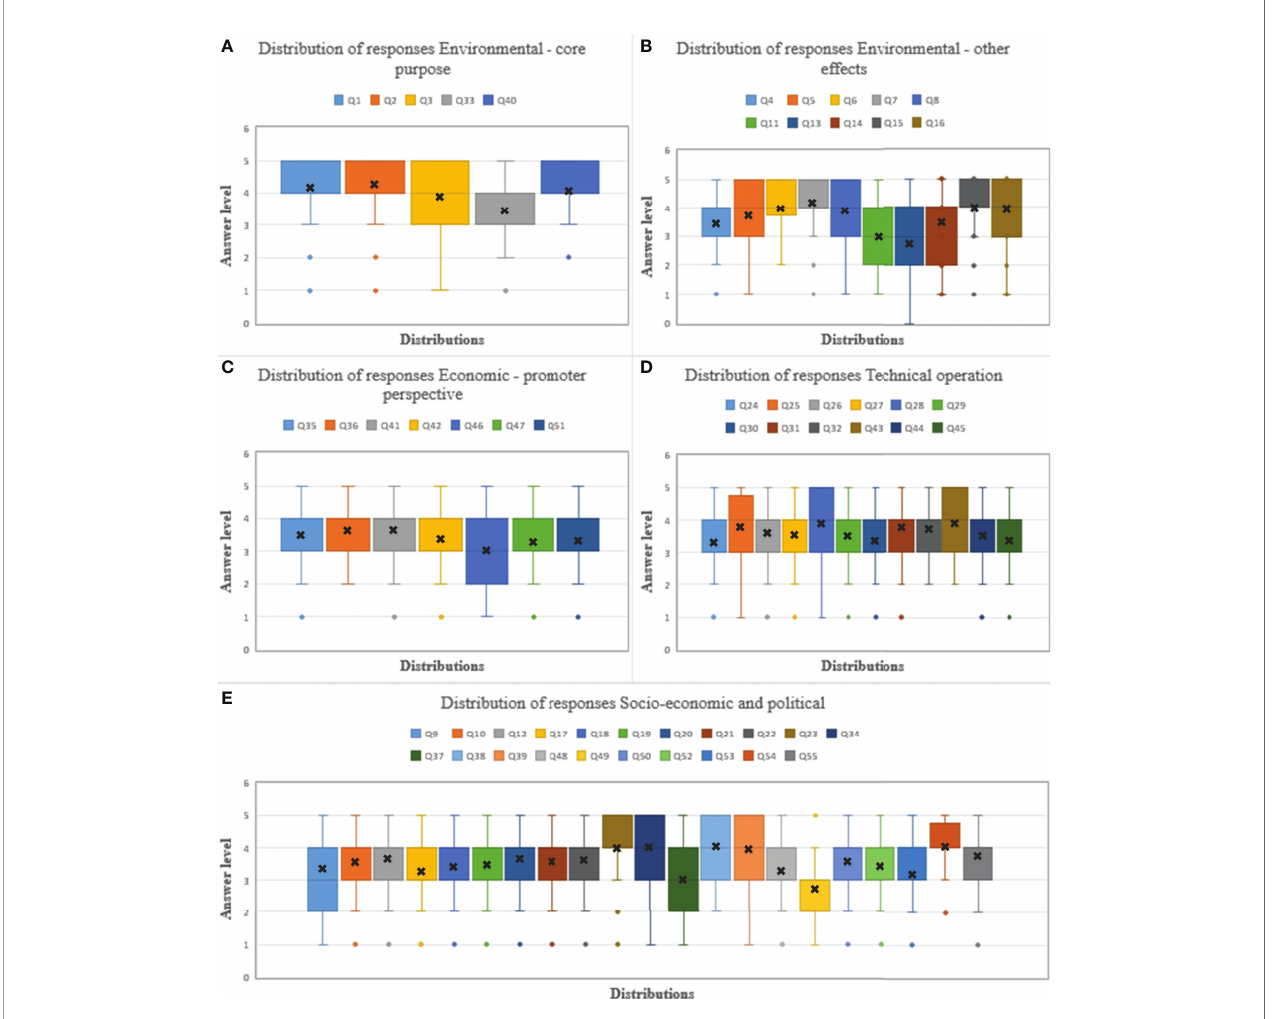
FIGURE 8 | Distribution of the responses per